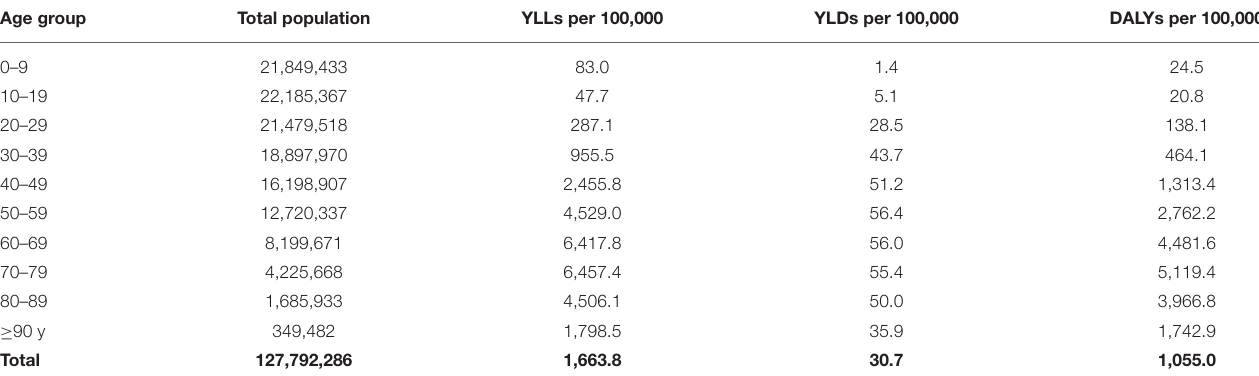
TABLE 5 | YLLs, YLDs, and DALYs per 100,000 inhabitants in